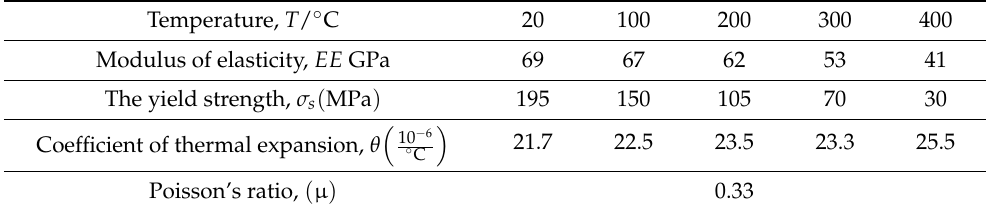
Table 3. Mechanical property parameters of AlSi10Mg alloy material.